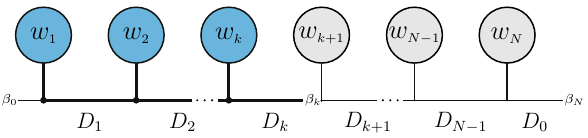
Fig. 2 Diagrammatic representation of an N -point open loop with k dressed and N − k undressed segments. The segment containing the last subtree, w N ≡ w 0 , is associated with the propagator ¯ D N ≡ ¯ D 0 = ¯ q 2 − m